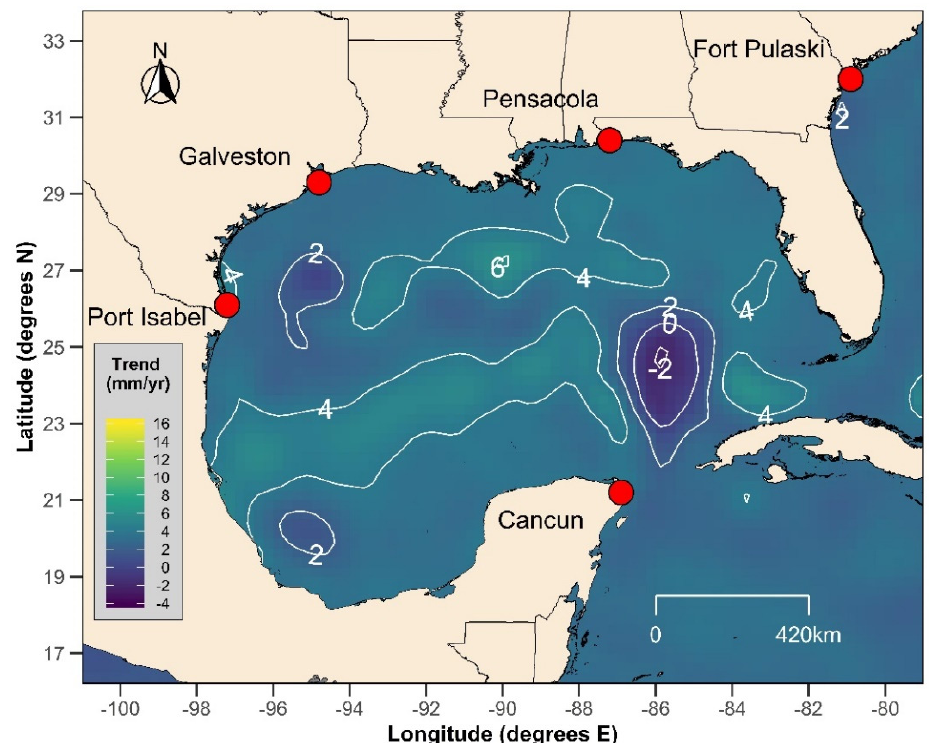
Figure 8. Panel 2—SSHA Trends (September 1992–October 2019) from AVISO data [30]. Trend contours are advised at 2 mm/year intervals. Refer also to Figure 6.